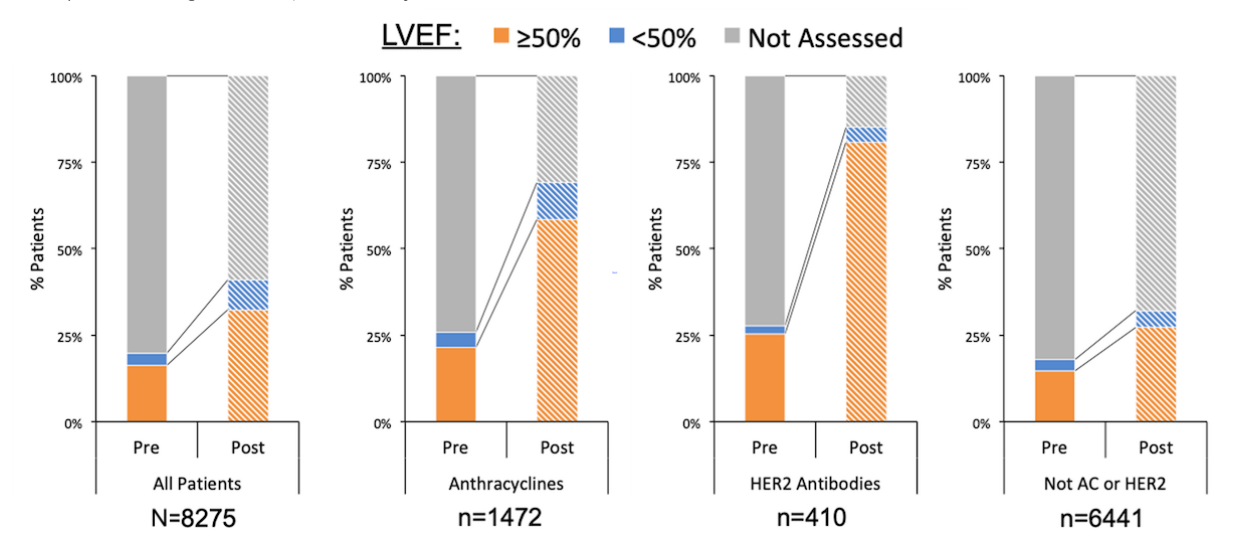
Figure 2. Documented LVEF assessment before and after cancer therapy. LVEF: left ventricular ejection fraction; HER2: human epidermal growth factor receptor 2 blocking antibodies; AC: anthracyclines.